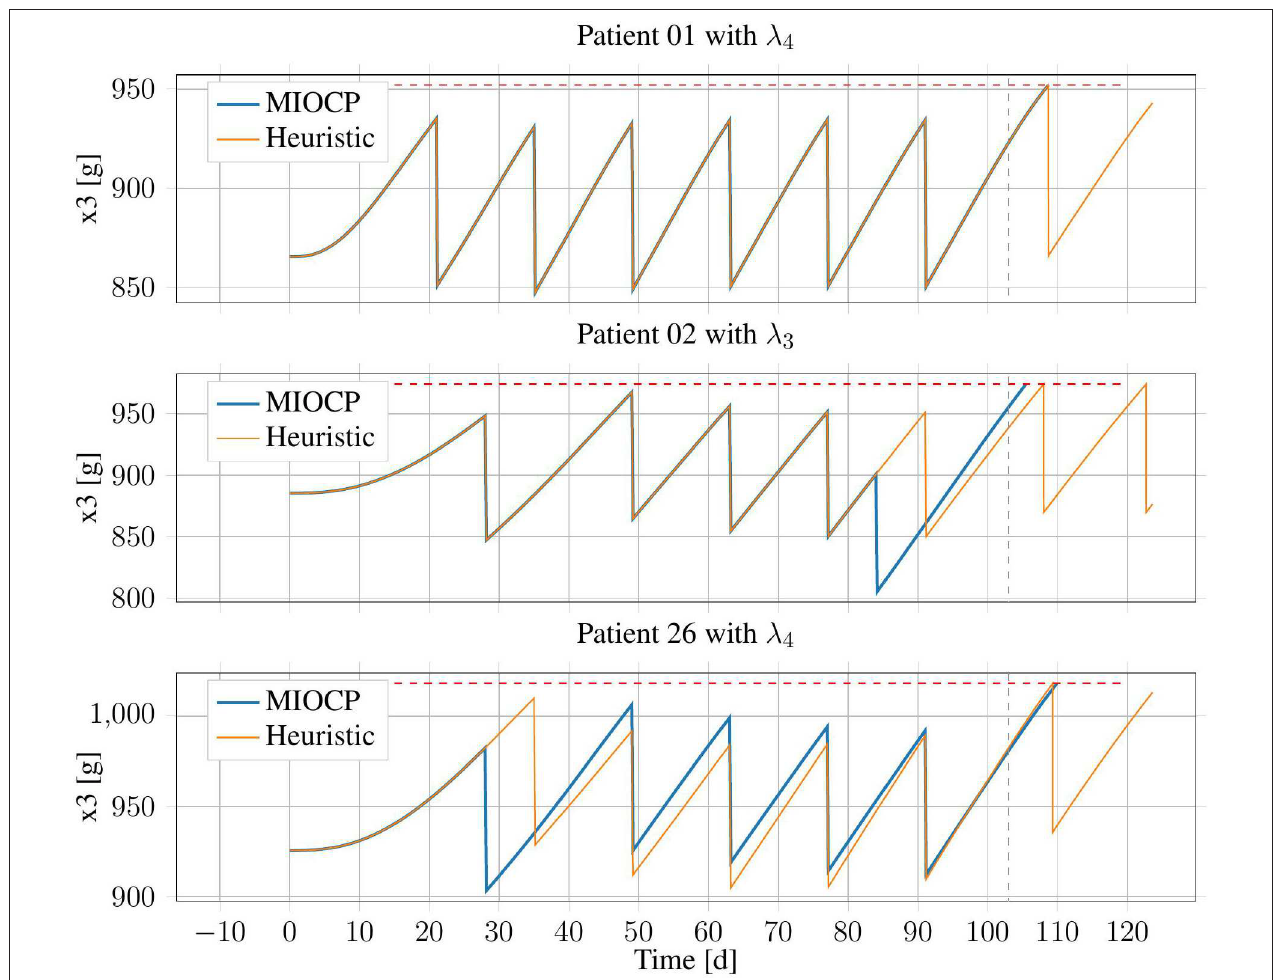
FIGURE 5 | Erythrocyte trajectories of three exemplary patients using IP-Schedules and HC-Schedules. The upper threshold (red, dashed) and the end of the time horizon at T = 103 days (gray, dashed) are marked.